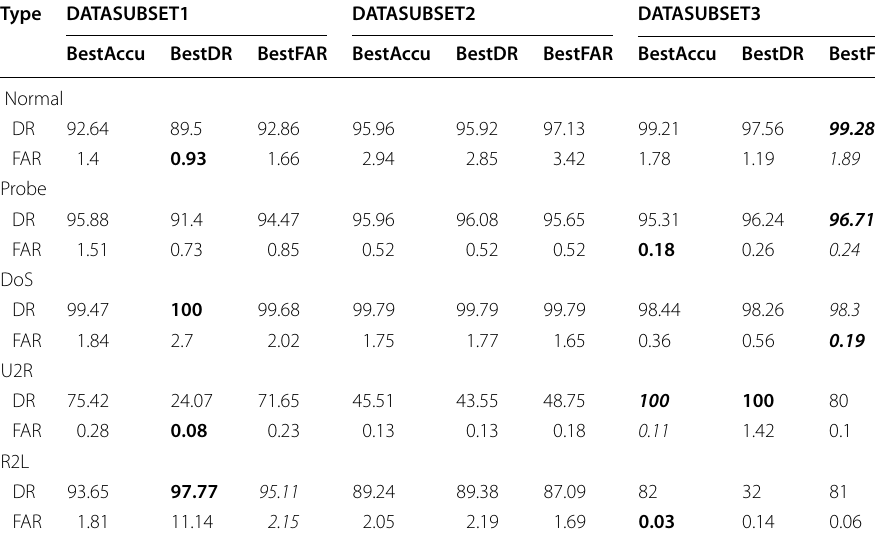
Table 5 Performance for different data subsets Type DATASUBSET1